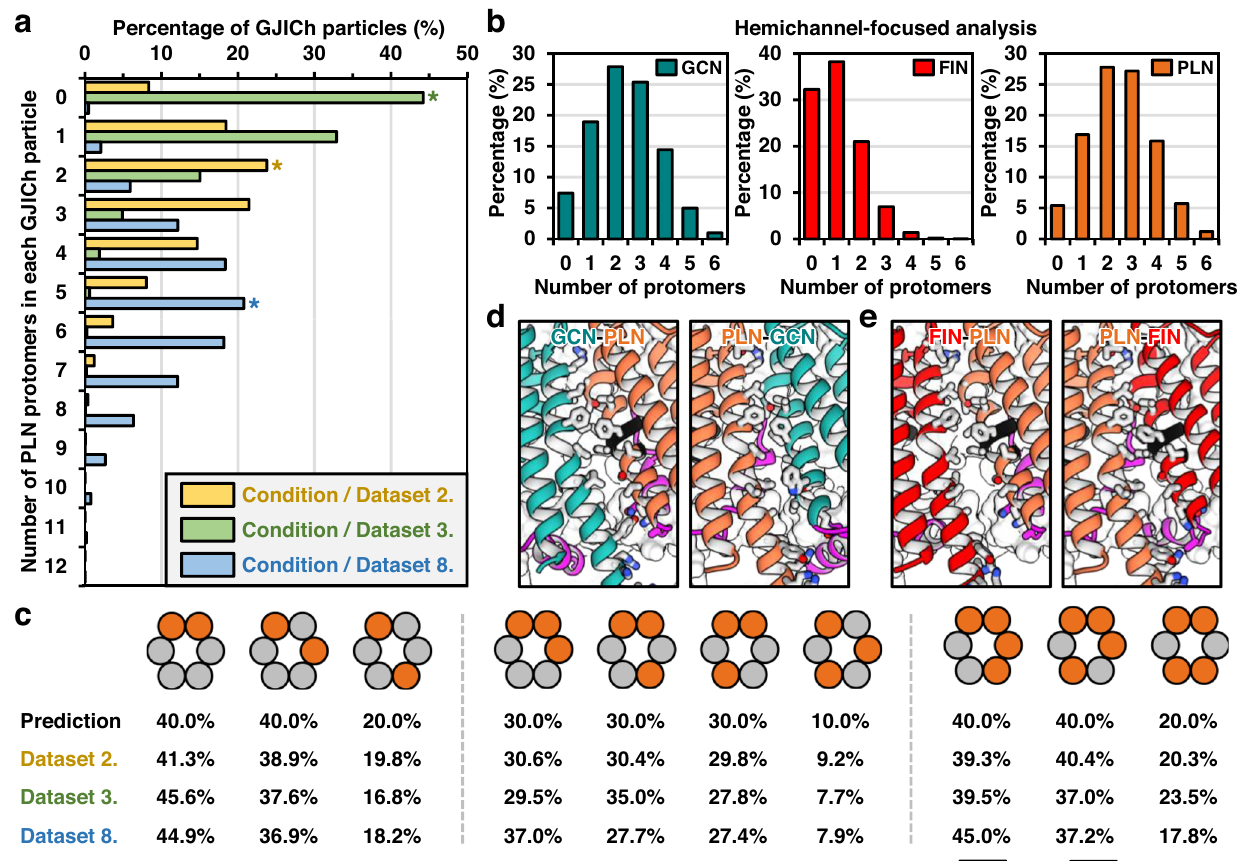
Fig. 4 | Distribution of different protomer conformations in Cx43 GJICh par- ticles. a Distribution of various compositions of PLN protomers within GJICh par- ticles. Three datasets of Cx43in detergents and nanodiscs wereanalyzed.For each dataset,thehighestpercentageisindicatedbyanasterisk. b Distributionofvarious compositionsof GCN(left),FIN(middle),and PLN(right)protomersineachhalfof the GJICh particles for Cx43-M257 in POPE nanodiscs (condition 8). c Schematic drawings for the possiblearrangements of PLNprotomersin hemichannelsforthe